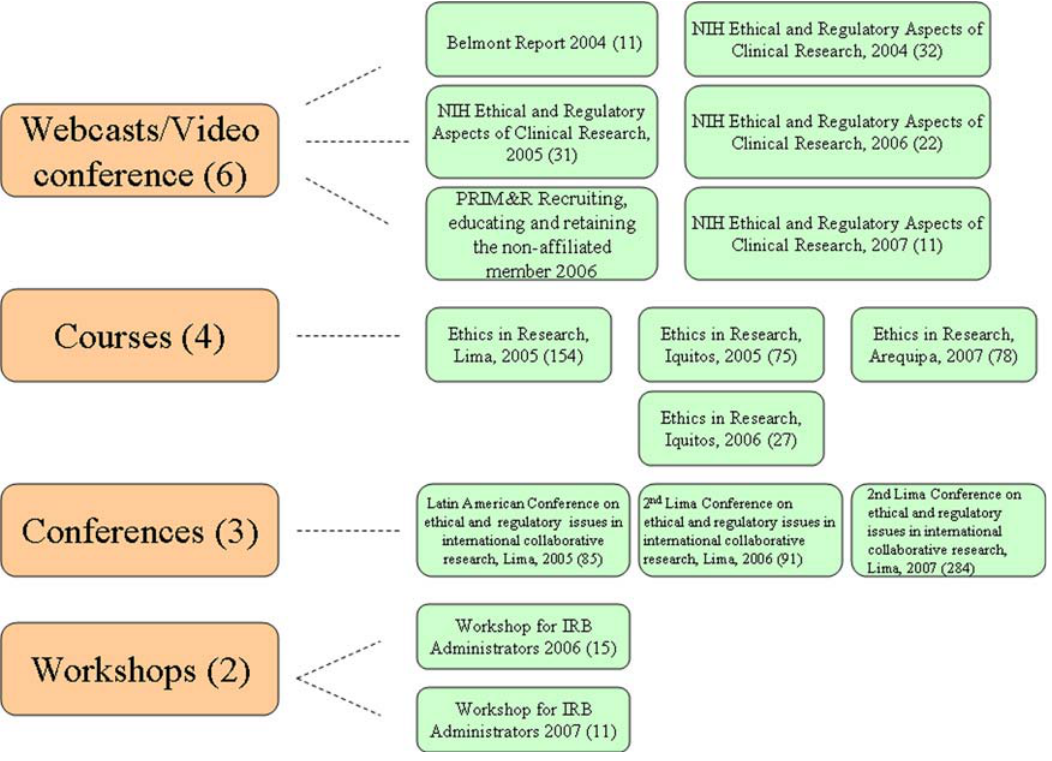
Figure 3. Training activities conducted.